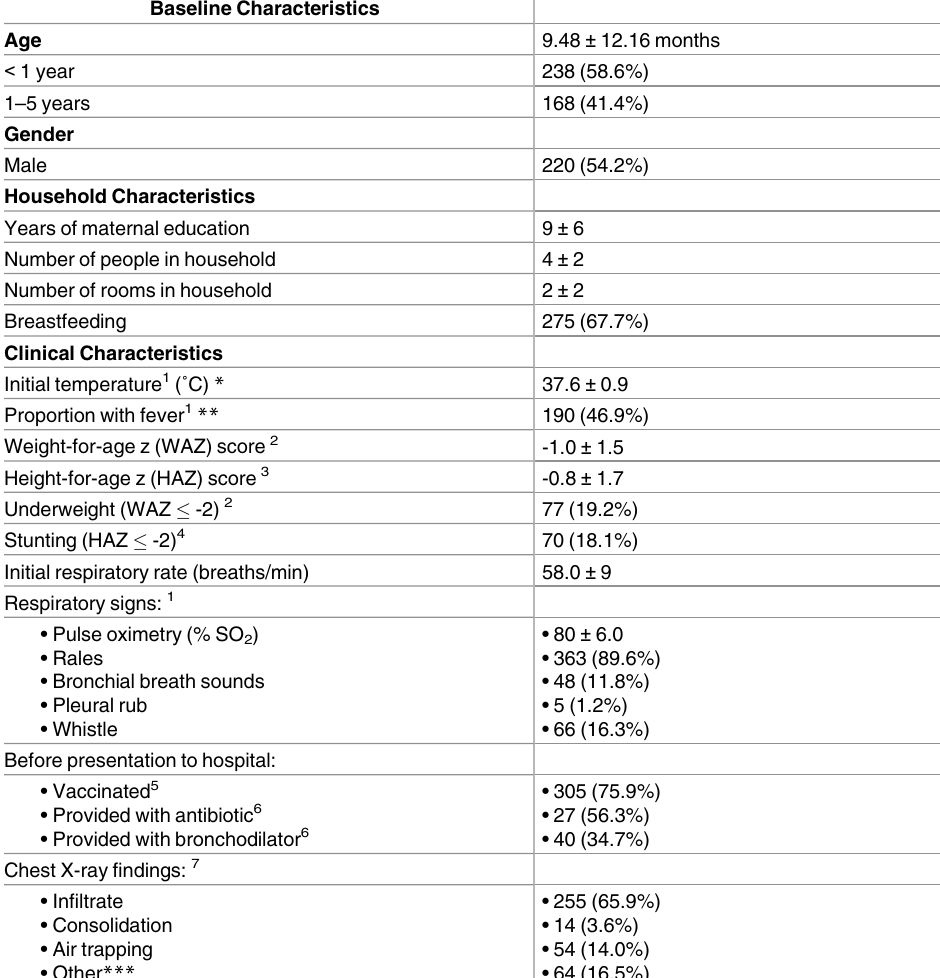
Table 1. Baseline characteristics of children with severepneumonia (N =